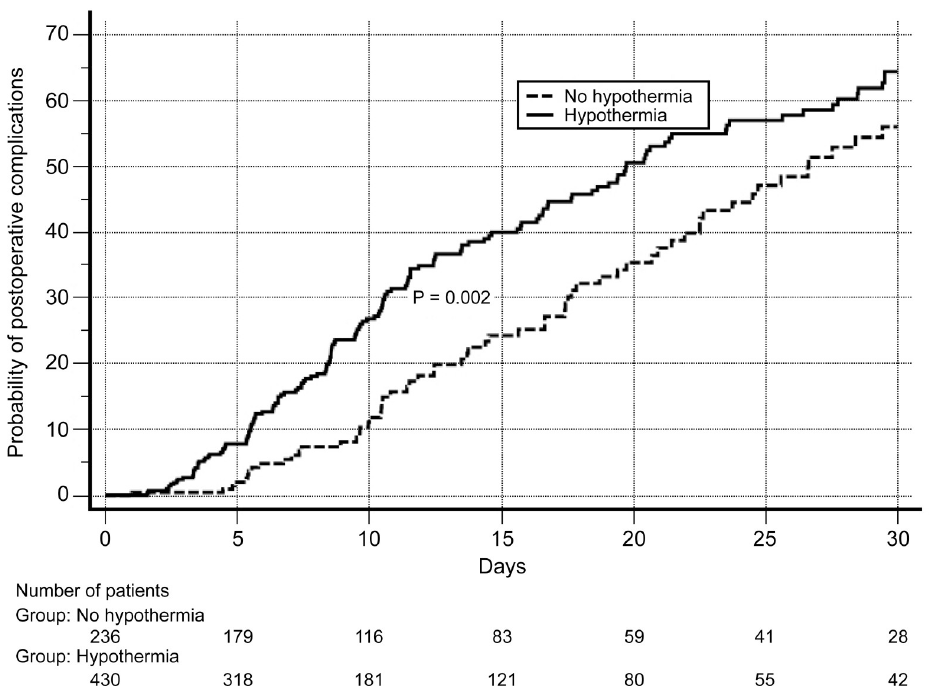
Fig 3. Kaplan–Meier curve of complications and hypothermia. Data were adjusted for age, comorbidities, abdominal surgery, and duration of surgery.